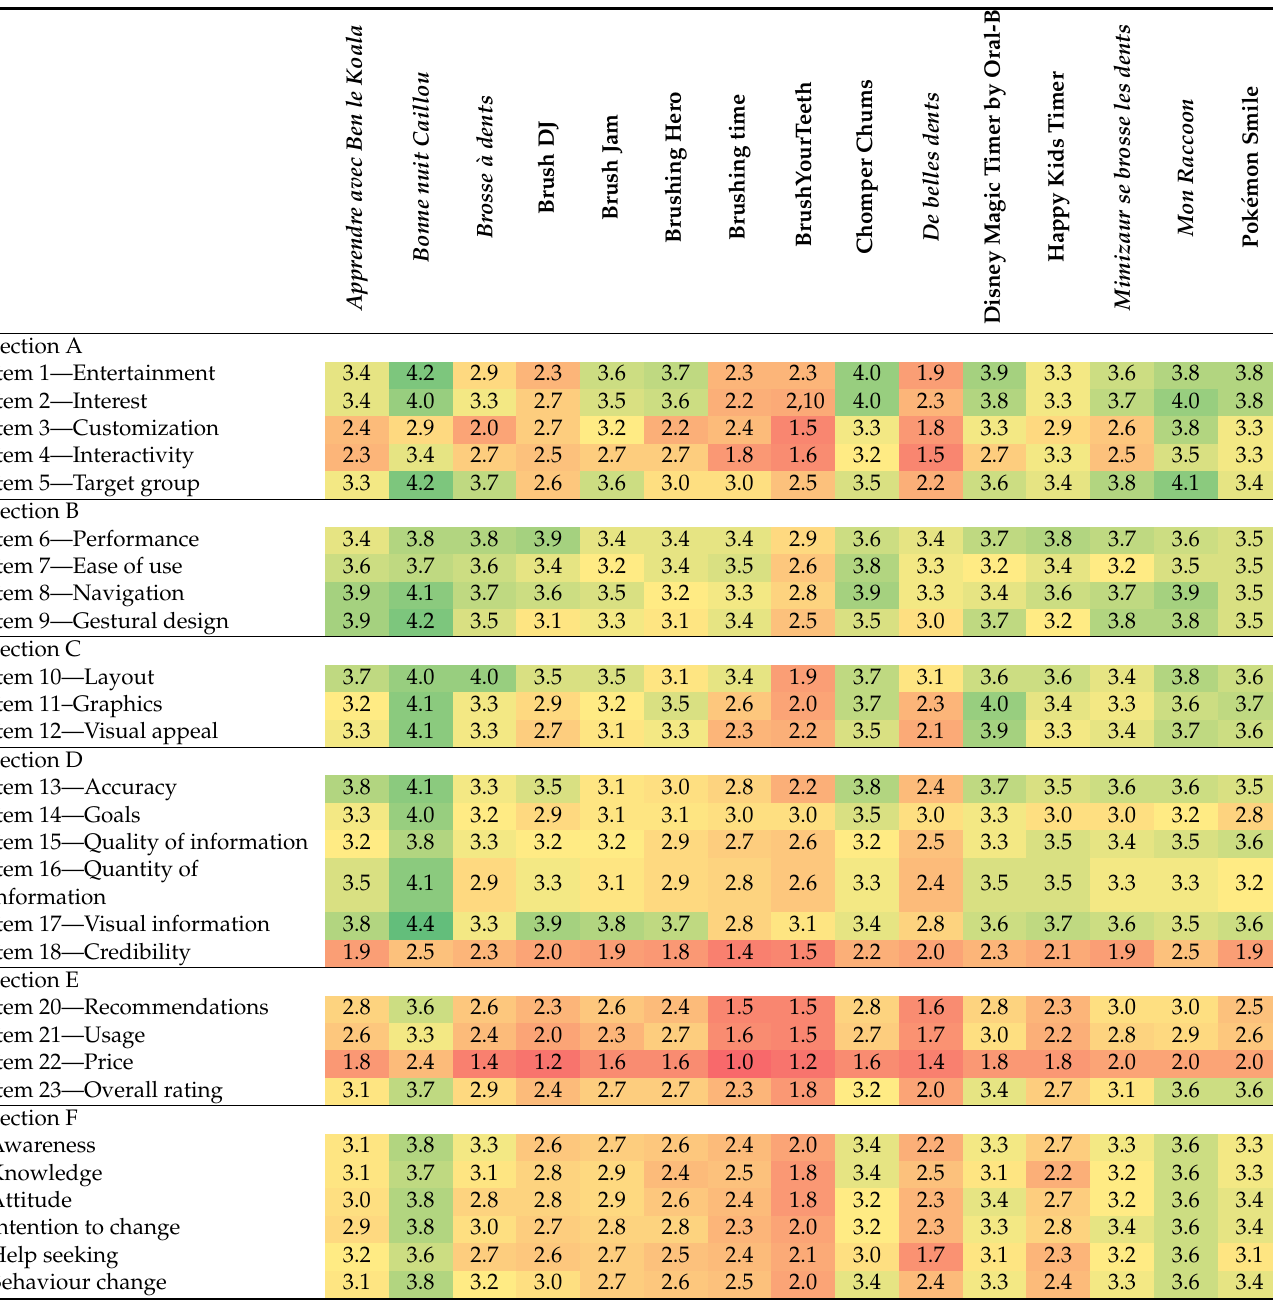
Table 2. Heatmap of the mean scores per application and per item. The colors are linked to the scores and range from red (1: worst score) to green (5: best